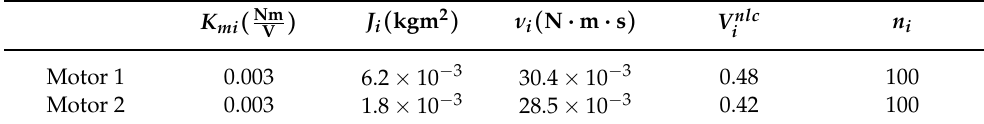
Table 1. Parameters of the motors.